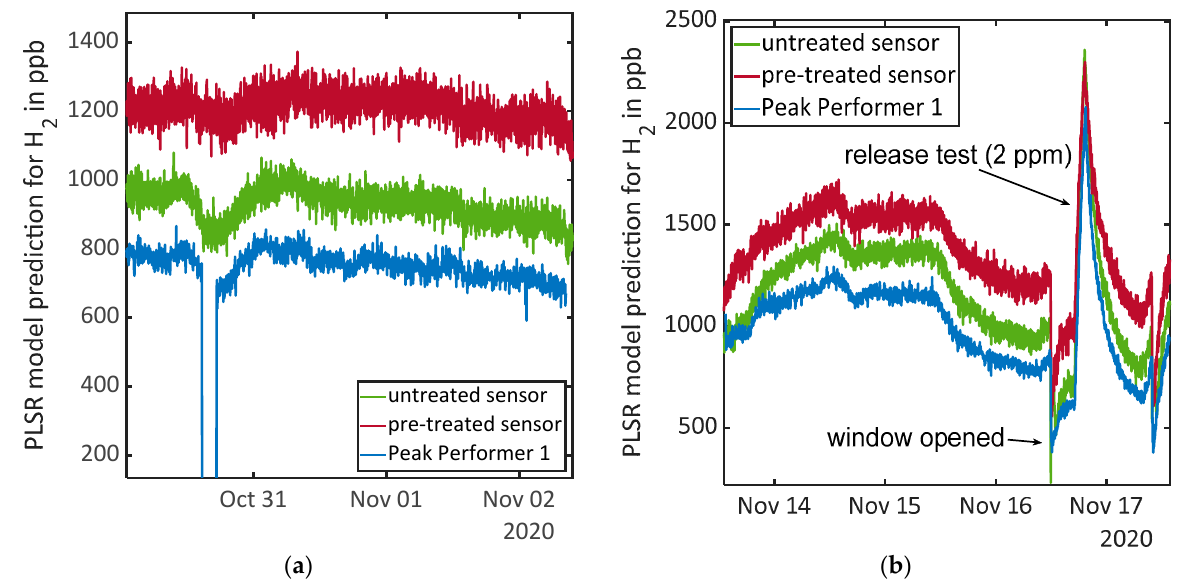
Figure 4. PLSR model predictions for H 2 for both sensors (untreated and pre-treated) compared to an analytical reference instrument (Peak Performer 1): ( a ) a weekend without additional events, the reference instrument was not connected to the pump for a short period of time and indicates 0 ppb during that period; ( b ) during a weekend followed by a release test with a calculated concentration increase of 2 ppm H 2 .